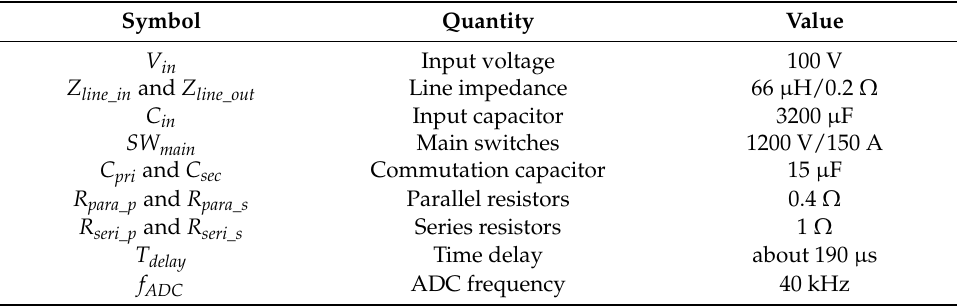
Table 2. Parameters of the experimental conditions.